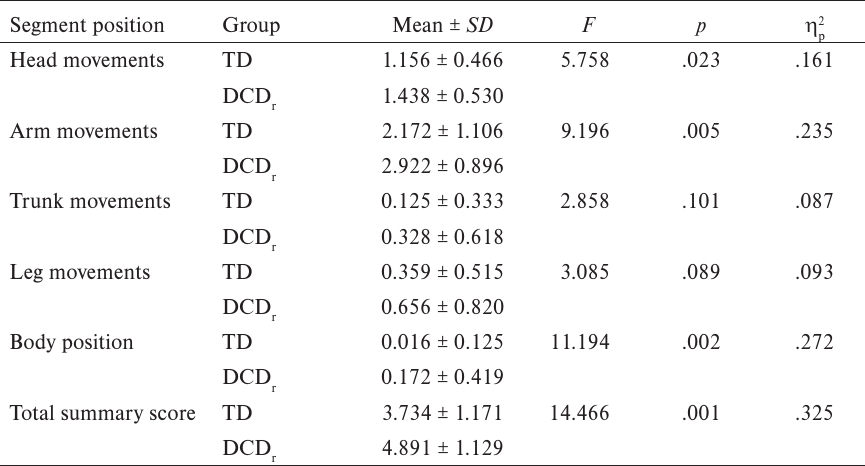
Statistical outcomes by ANOVA for the differences in observed body segments between the TD group and the DCD group r Segment